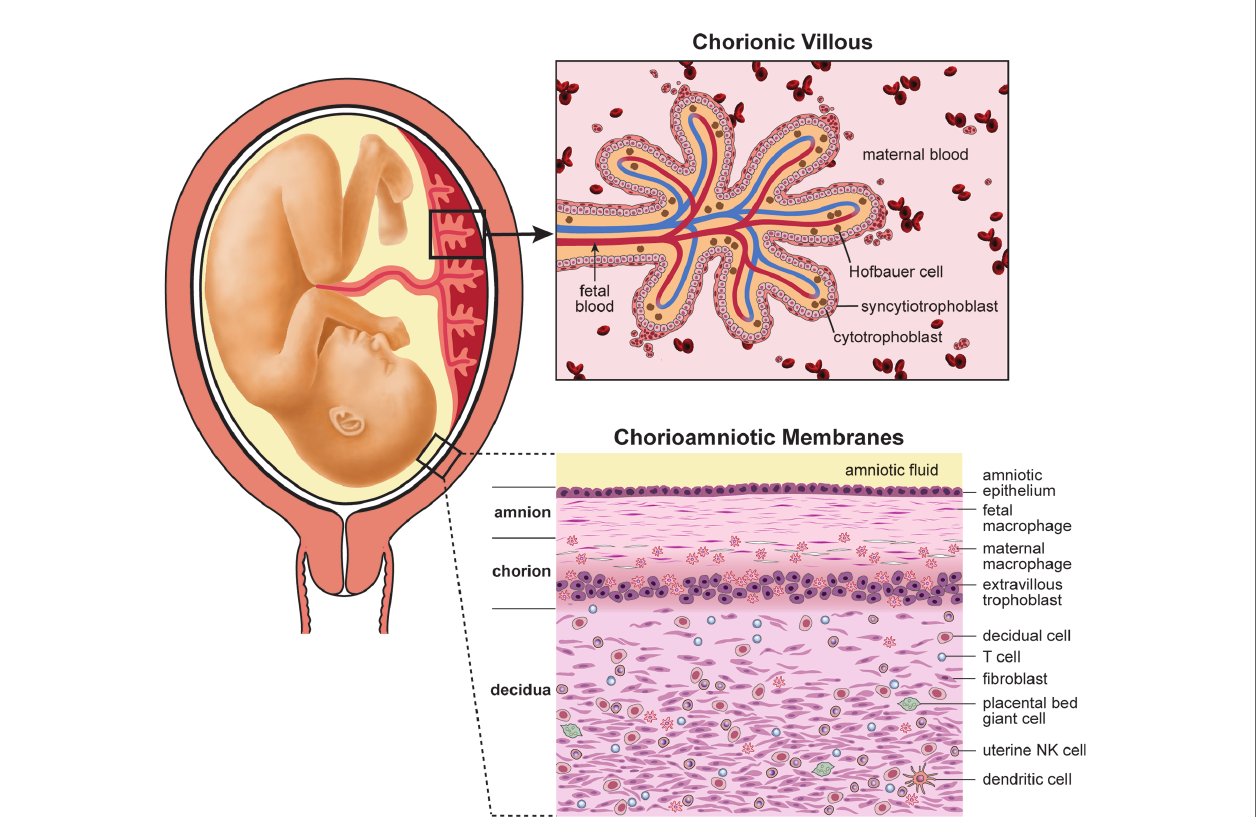
FIGURE 4 | Human placental anatomy. This illustration depicts the components of the human placenta (chorionic villous tree), placental chorioamniotic membranes and the associated maternal decidua. GBS must traf fi c across either the decidua and chorioamniotic membranes or the chorionic villi to infect the fetus. GBS chorioamnionitis and culture-positive amniotic fl uid is common in cases of fetal or neonatal invasive disease; thus, it is thought that GBS invasive disease occurs most commonly due to traf fi cking across the chorioamniotic